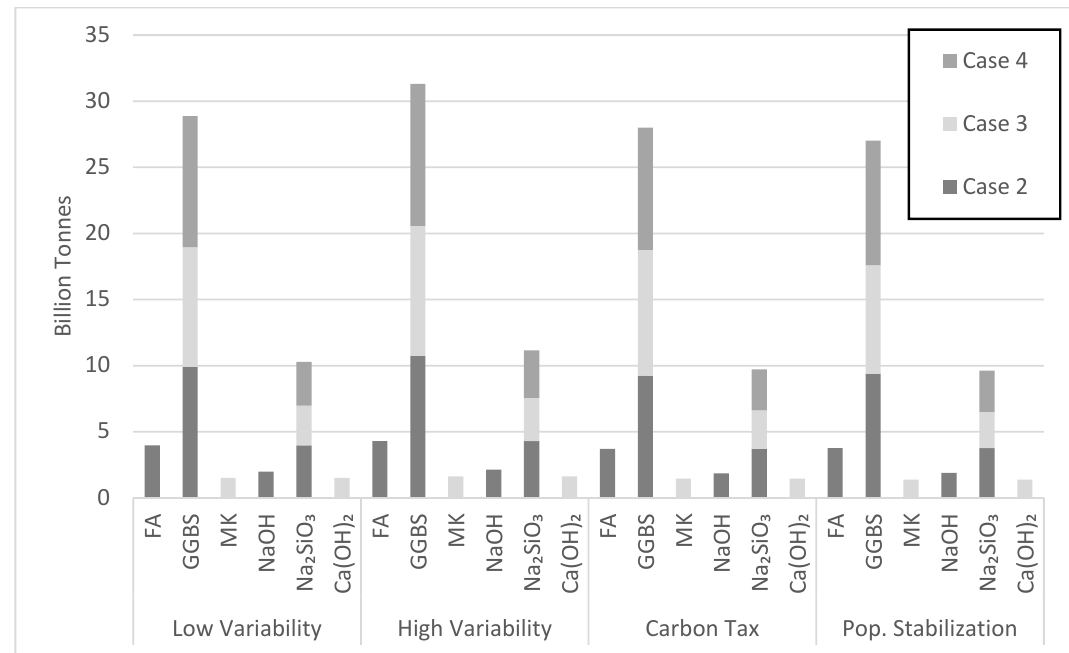
Figure 19. Total projected amount of precursor and activator utilized by the year 2050.